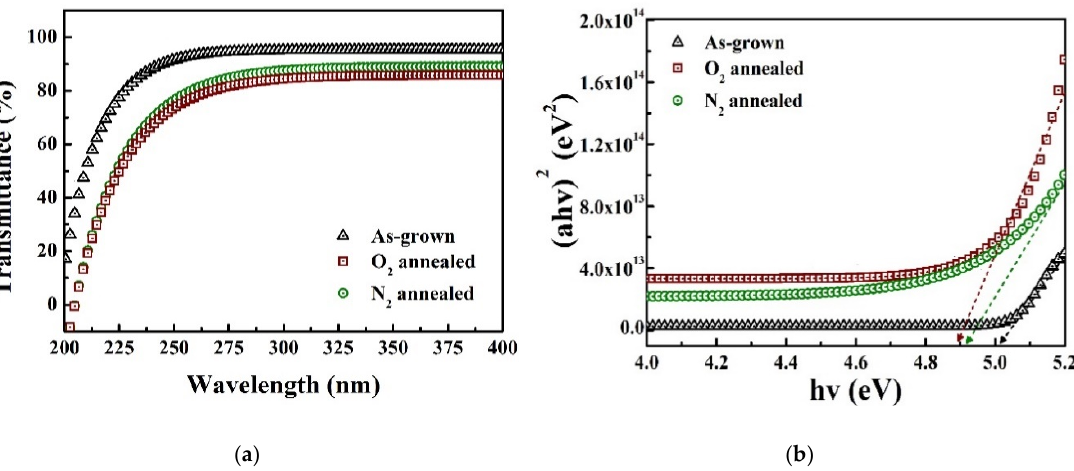
Figure 3. ( a ) Transmittance spectra and ( b ) (αhν) 2 –hν plots of Ga 2 O 3 film samples annealed under different atmospheres.